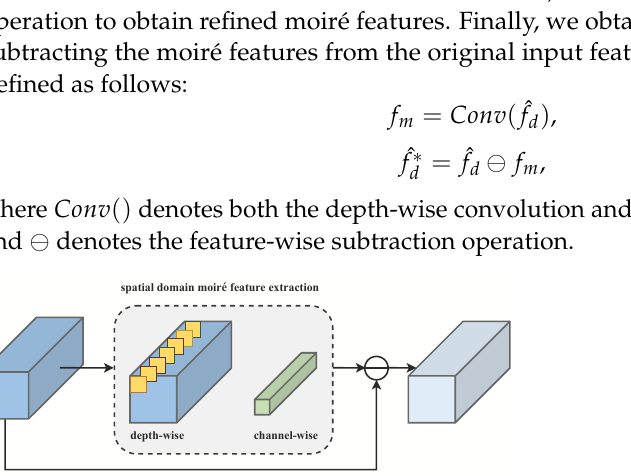
Figure 3. The structure of the spatial domain demoiré block